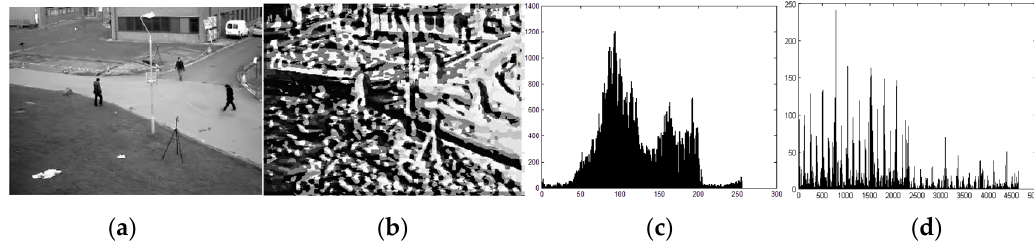
Figure 3. ( a ) The gray scale image of the original image; ( b ) the texture image of the background; ( c ) the histogram of the original image; and ( d ) the LBP histogram of the background image, which shows extensive information of the texture.